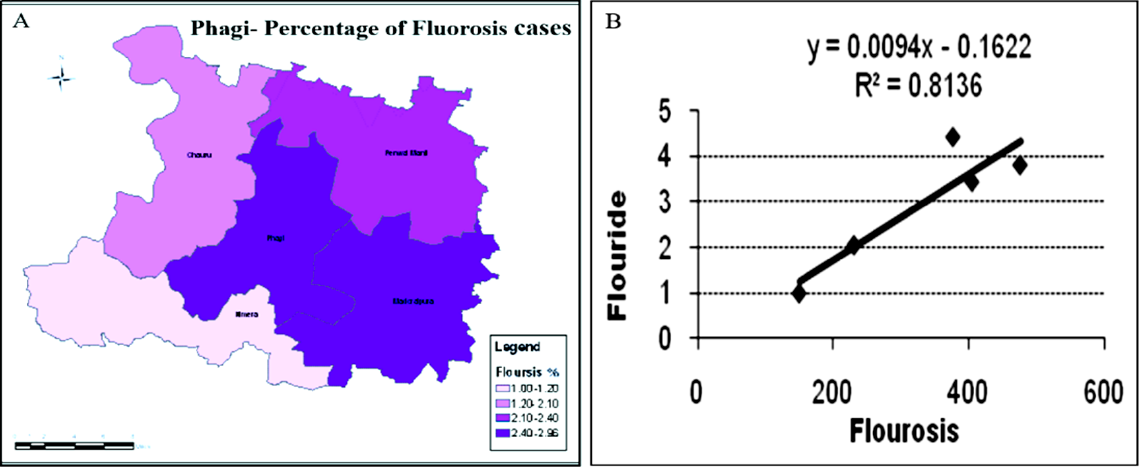
Figure 6. Percentage of Fluorosis cases recorded. ( A ) linear regression analysis between fluorosis cases and fluoride content in water ( B ).